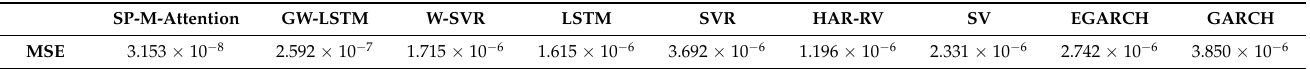
Table 7. Volatility prediction of different models on the high frequency of the Shanghai Composite Index.